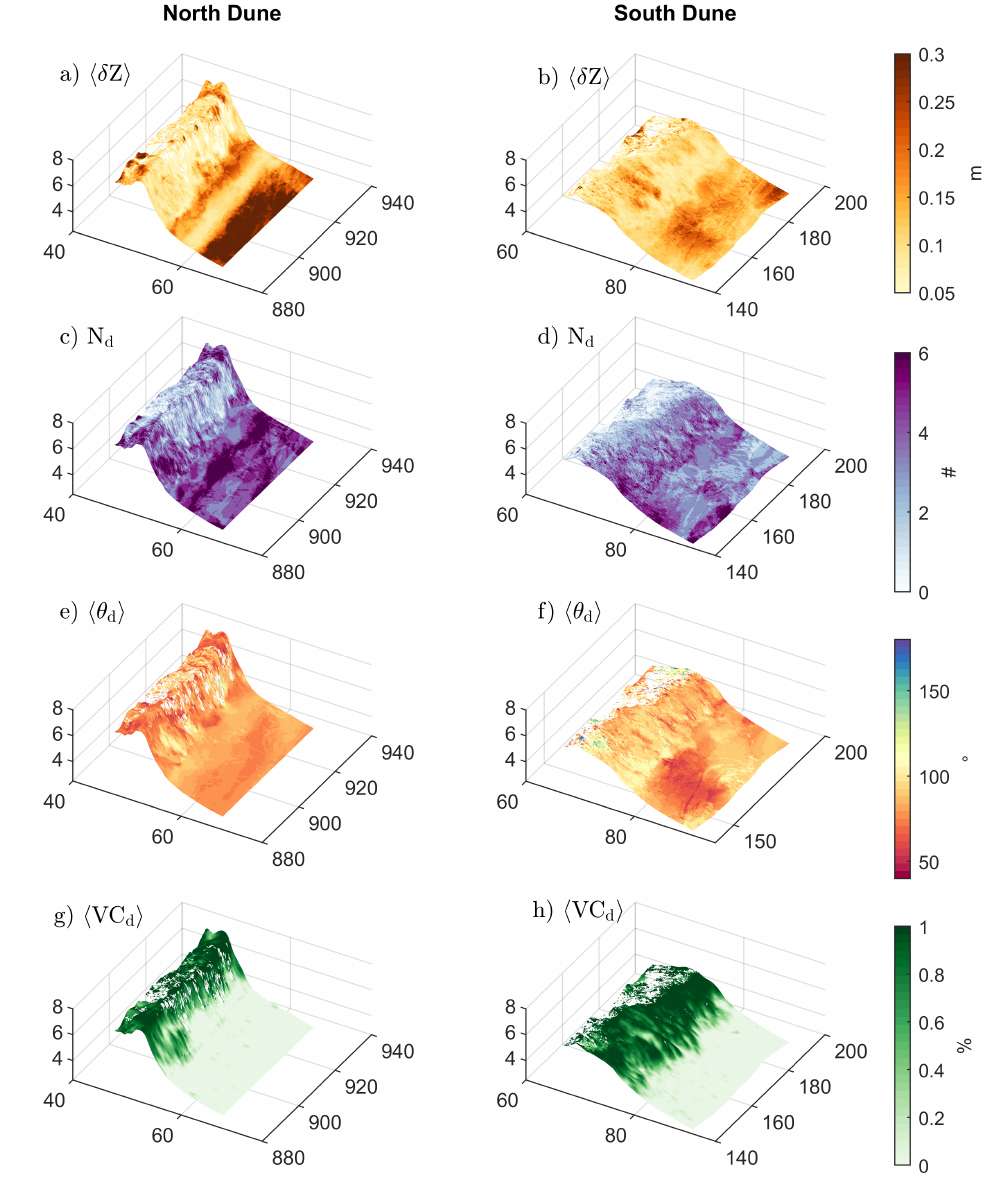
Figure 11. Spatial variability in dune deposition and corresponding forcing factors. ( a , b ) The interval-averaged magnitude, (cid:104) δ Z i (cid:105) , and ( c , d ) number of deposition events, N d , ( e , f ) average wind direction, (cid:104) θ d (cid:105) , and ( g , h ) and vegetation coverage, (cid:104) VC d (cid:105) , as a function of cross-shore position, alongshore position, and elevation, during the deposition intervals for the north and south dunes, respectively. Colors at right show the magnitude of each